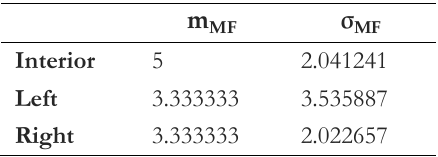
Table 10. Sample result of the uncertainty measures for T1FS models.